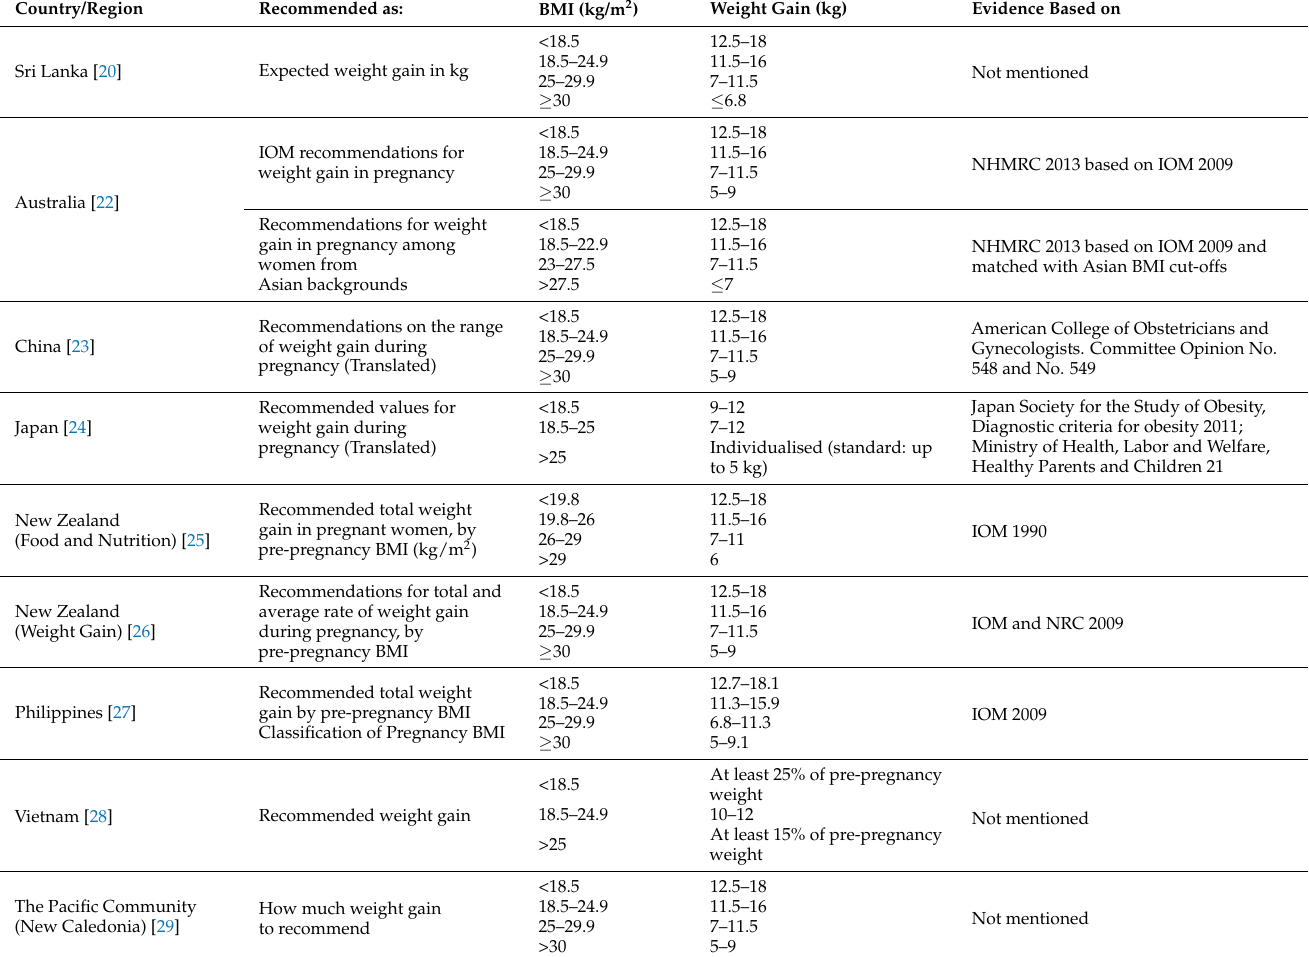
Table 4. Recommendations on GWG in